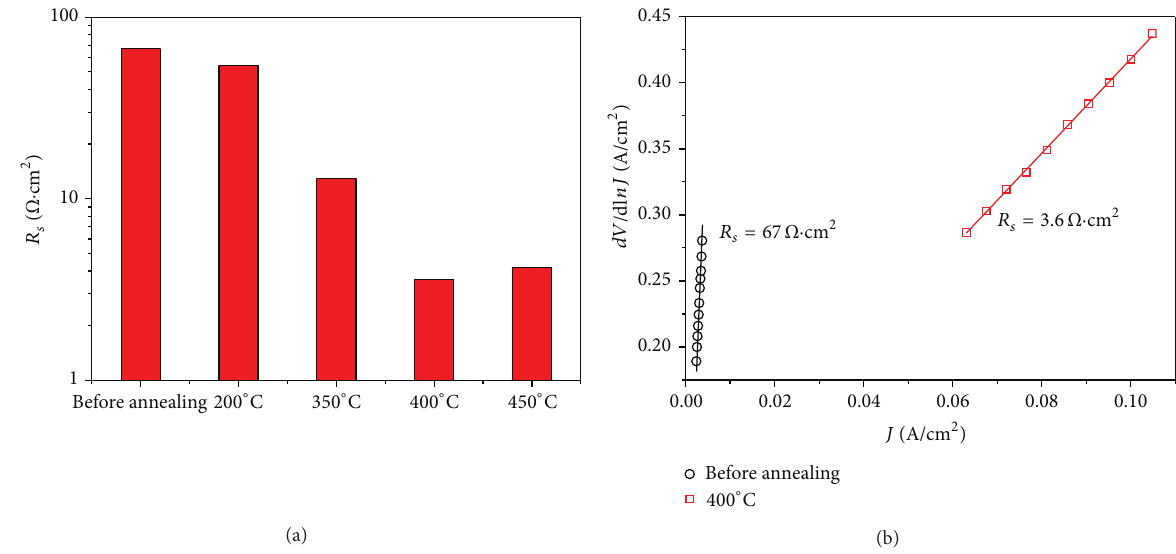
Figure 2: (a) The evolution of series resistances ( 𝑅 𝑠 ) of the Gr-Si solar cell with thermal annealing temperature. (b) Typical examples showing how the 𝑅 𝑠 values of the Gr-Si solar cell are extracted [5].